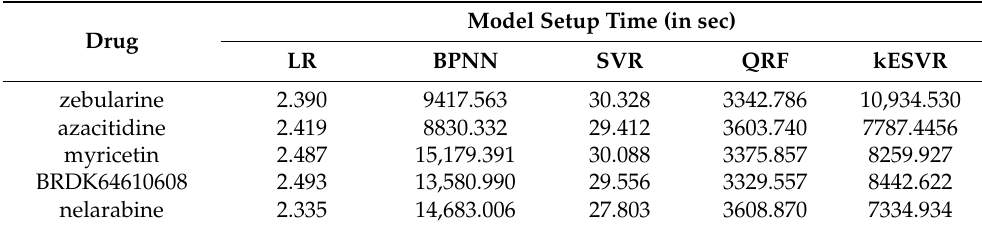
Table 3. Model setup time for 5 random drugs.